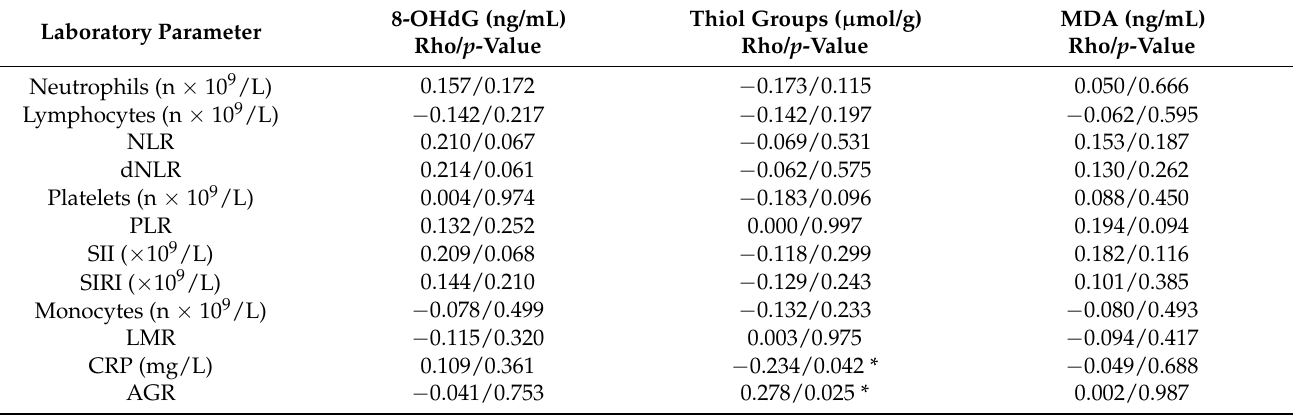
Table 4. Correlation of preoperative inflammatory and redox biomarkers in testicular GCT patients.